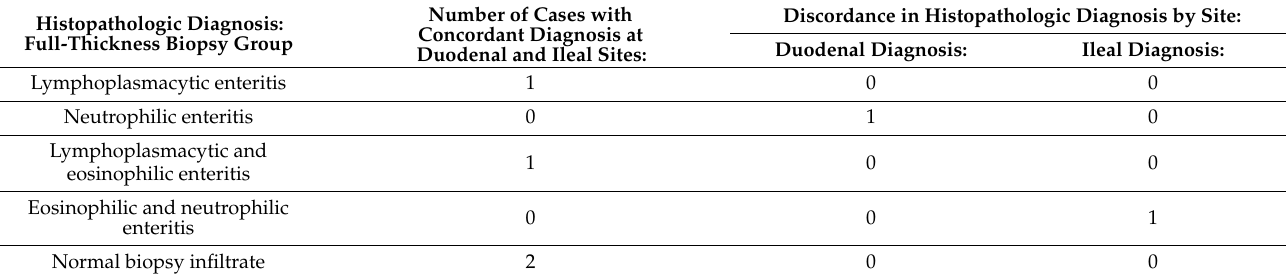
Table 2. Final histopathologic diagnosis following re-review of slides within the full-thickness biopsy group of inflamma- tory or neoplastic disease (5 dogs). Concordant cases represented first, followed by discordant cases where individual corresponding diagnosis per site is indicated.